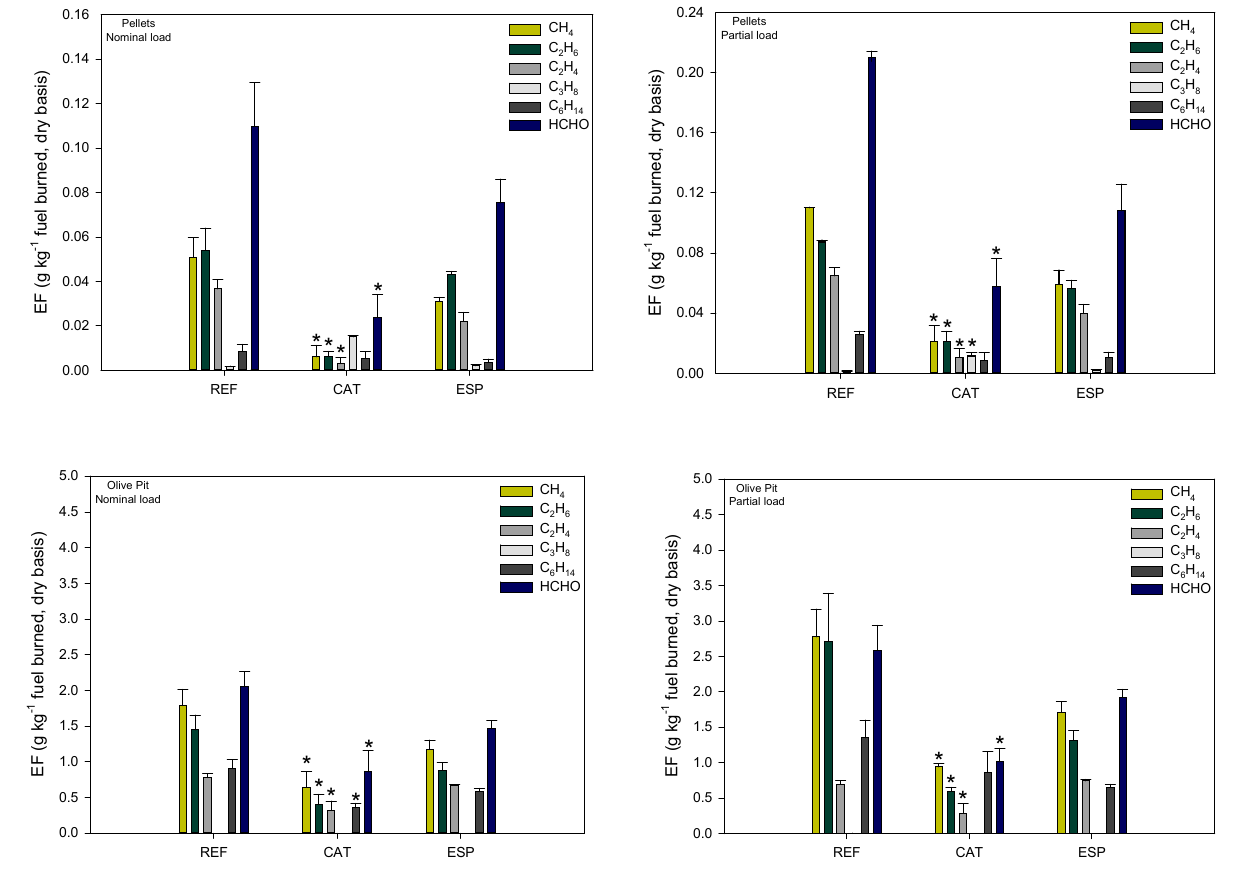
Figure 6. Emission factors of individual hydrocarbons (CH 4 , C 2 H 6 , C 2 H 4 , C 3 H 8 , C 6 H 14 , and HCHO) from wood pellet and olive pit combustion at nominal and partial loads with or without catalytic converter (CAT) and electrostatic precipitator (ESP). Asterisks indicate a statistically significant difference compared to the reference condition (REF) ( p < 0.05; Kruskal–Wallis test).